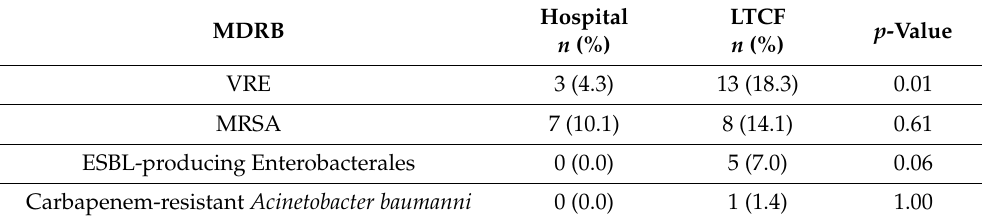
Table 2. Isolation of MDRB from HCW in hospitals ( n = 69) in comparison to LTCF ( n =